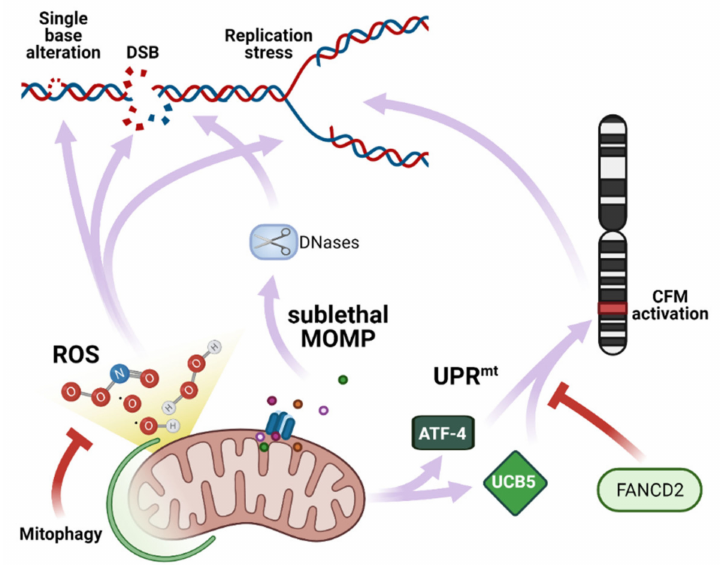
Figure 3. Mitochondrial response to DNA damage. Mitochondria directly induces DNA damage via ROS production, the activation of DNase during sublethal MOMP or activation of CFM mediated by UPR mt